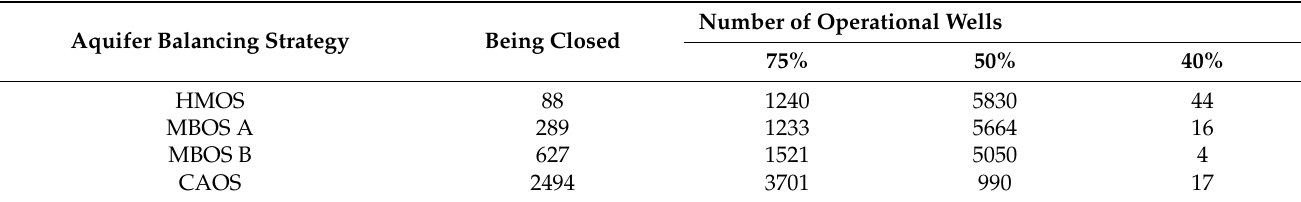
Table 3. Number of wells with a reduction in the withdrawal after application of the strategies.